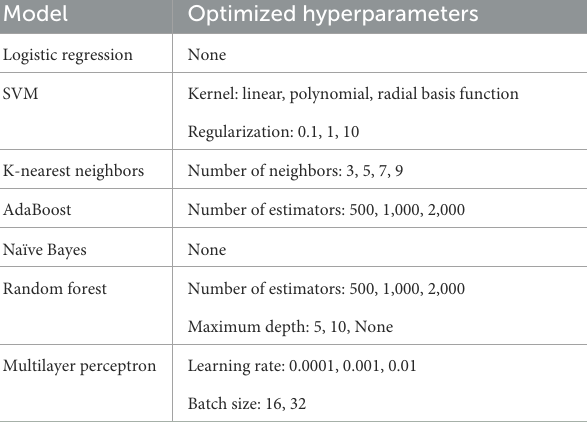
TABLE 1 The coefficient of correlation ρ (Pearson) between the degree of engagement and the various features proposed in our analysis. Feature ρ Feature